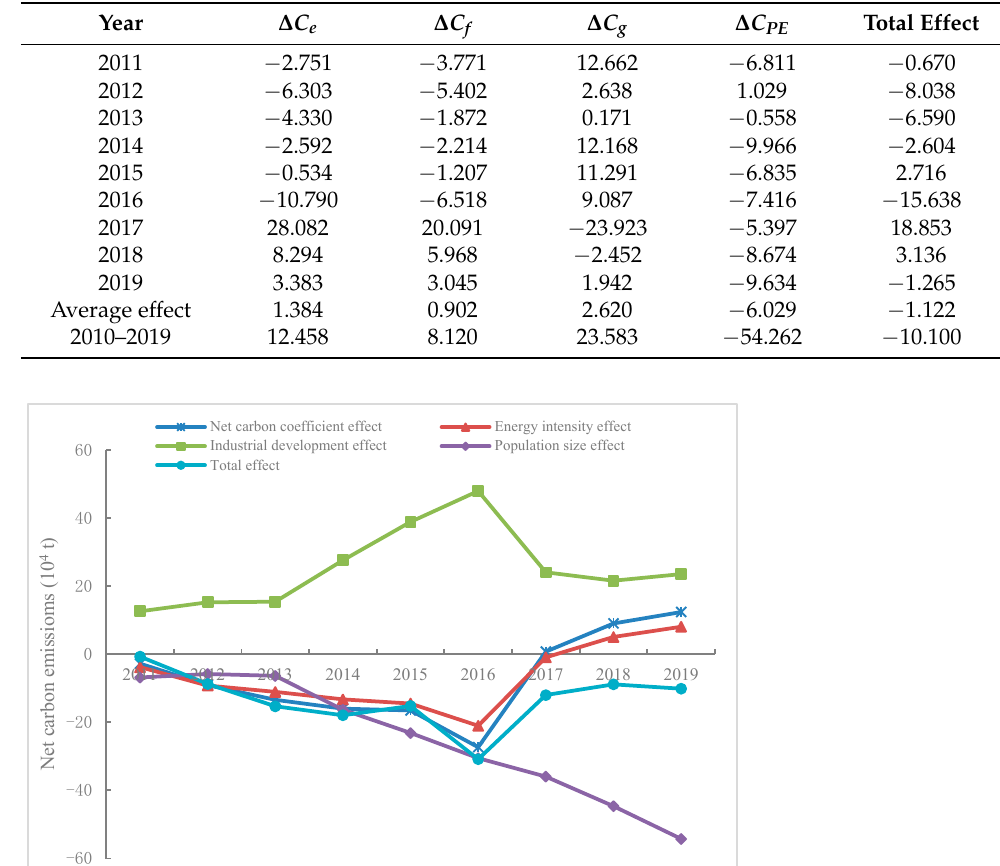
Table 2. Decomposition results of net carbon emissions from China’s offshore fishing industry from 2010 to 2019 (10 4 t).